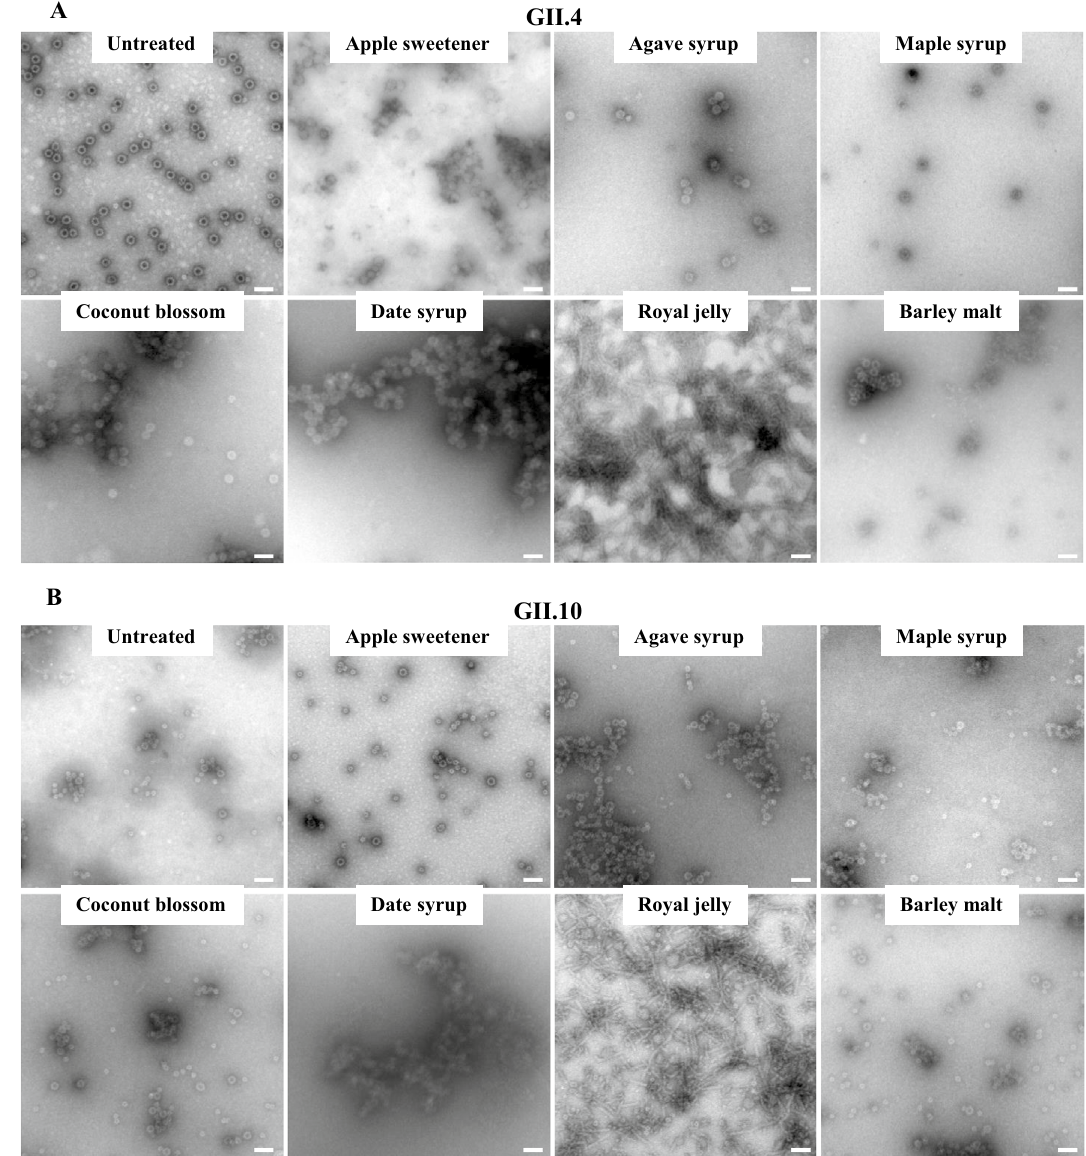
Figure 3. Natural extracts and EM analysis of GII.4 and GII.10 VLPs. Negative stain EM was used to evaluate the integrity of VLPs after natural extract treatment (final concentration of extracts 12.5%). With royal jelly, long rod-like shapes (from the jelly sample) obscured visualizing the treated VLPs. ( A ) Untreated GII.4 VLPs showed the typical T = 4 structure of VLPs. Agave syrup and maple syrup treated GII.4 VLPs closely resembled untreated VLPs. Treatment with apple sweetener and barley malt resulted in the formation of small aggregates. Treatment with coconut blossom syrup and date syrup led to the formation of larger GII.4 VLP aggregates. ( B )